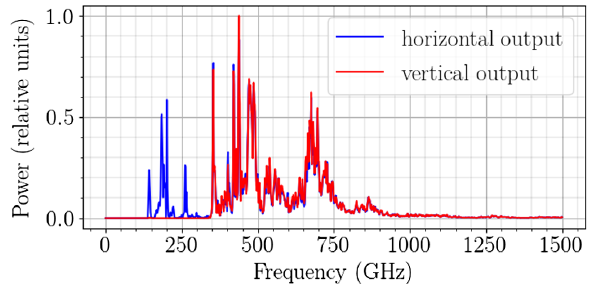
FIG. 21. Baseline IOM energy spectrum for a bunch with 100 μ m vertical